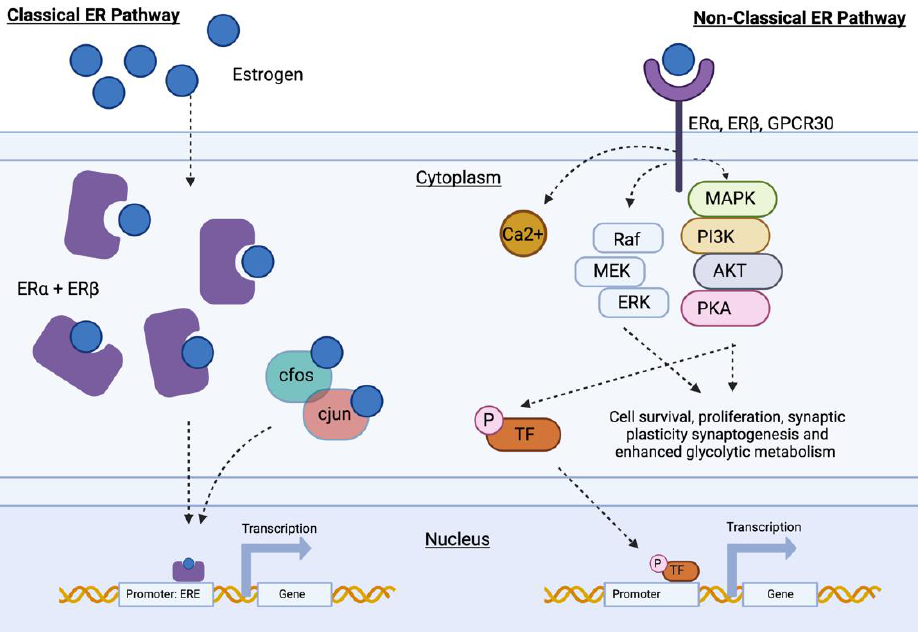
Figure 1. Schematic diagram showing the proposed mechanism of classical and non-classical estrogenic action. Activation of the classical ER pathway ( left ) involves nuclear ER found in the cytoplasm directly binding to EREs within target gene promotor regions. Transcription factors, such as c-fos and c-jun, facilitate binding of the nuclear ER to begin gene transcription. The non-classical pathway ( right ) is facilitated through membrane-bound ER. Upon ligand binding, intracellular protein kinase cascades result in changes to the intracellular environment and activation of independent transcription factors. Abbreviations: ER α : estrogen receptor α ; ER β : estrogen receptor β ; ERE: estrogen response element; ERK: extracellular regulated kinase; GPCR30: G protein-coupled receptor 1; MAPK: mitogen-activated protein kinase; PI3K: phosphatidylinositol 3-kinase/Akt signaling; PKA: protein kinase A; Raf/ MEK: mitogen-activated ERK kinase signaling; TF: transcription factor.